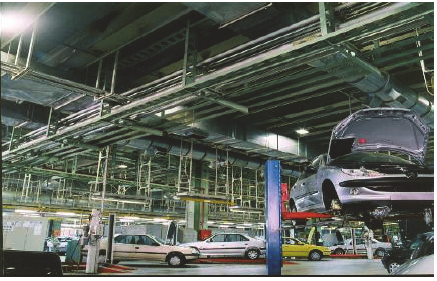
Fig. 12. Image of the Piping activitie Fig. 13. The image of the project after